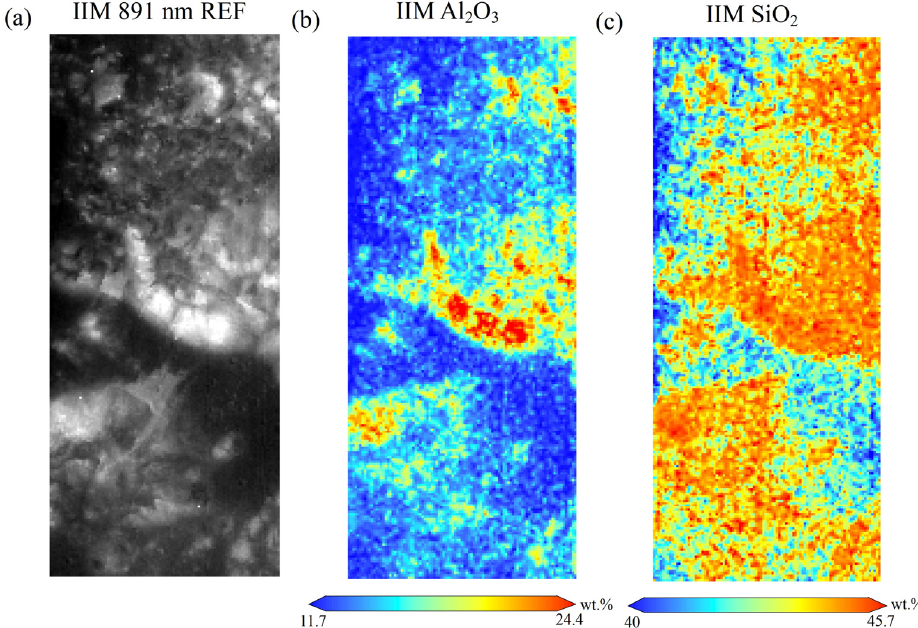
Figure 11. Apollo 17 area: ( a ) IIM 891 nm reflectance image, ( b ) Al 2 O 3 , ( c ) SiO 2 prediction results of the Extra-Trees model based on feature band selection.